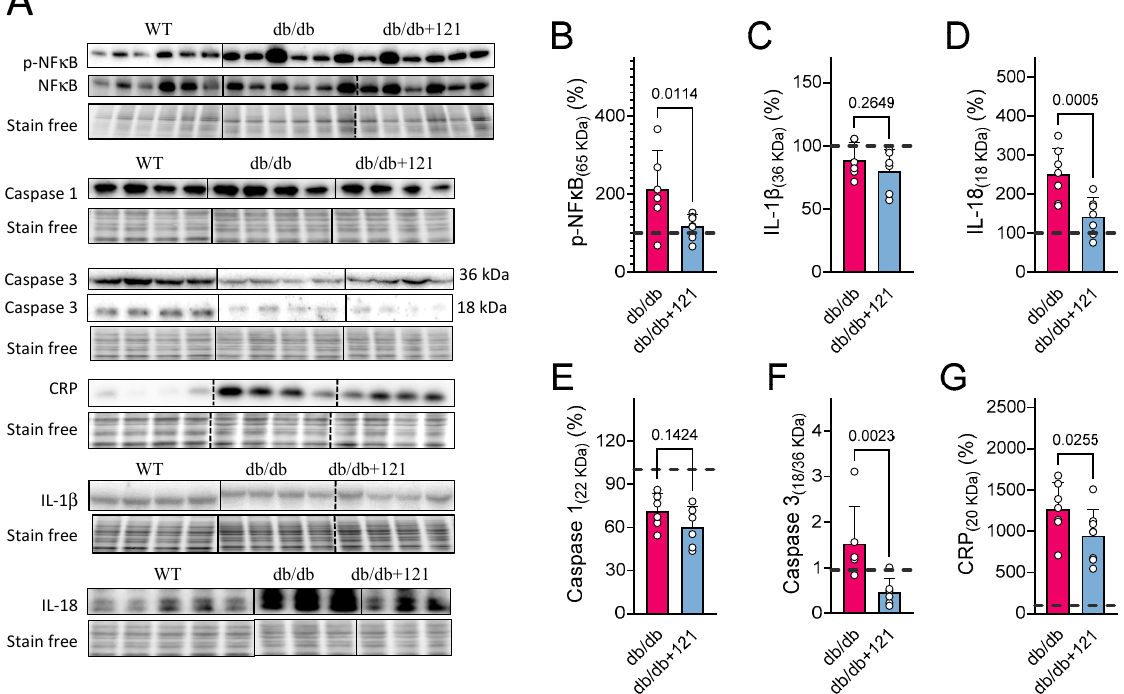
Figure 4. Liver inflammatory markers in db/db mice fed control diet or diet with CMS121. Representative blot images ( A ). Vertical lines indicate non-adjacent lanes from the same blot, and dashed lines adjacent groups. ( B – G ) Respective quantification of blots: ( B ) p-NF- κ B; ( C ) IL-1 β ; ( D ) IL-18; ( E ) Caspase 1; ( F ) Caspase 3 (cleaved/uncleaved), and ( G ) C-reactive protein (CRP). Data are presented as mean ± SD (n = 6–8), and p -values are indicated for the untreated control db/db mice compared to the CMS121-treated mice. Values were normalized to WT group (dashed line), and data are presented as percentages of WT values. One-way ANOVA was used to detect mean changes, and differences between db/db and db/db + 121 were evaluated by the Holm–Sidak post-hoc test.